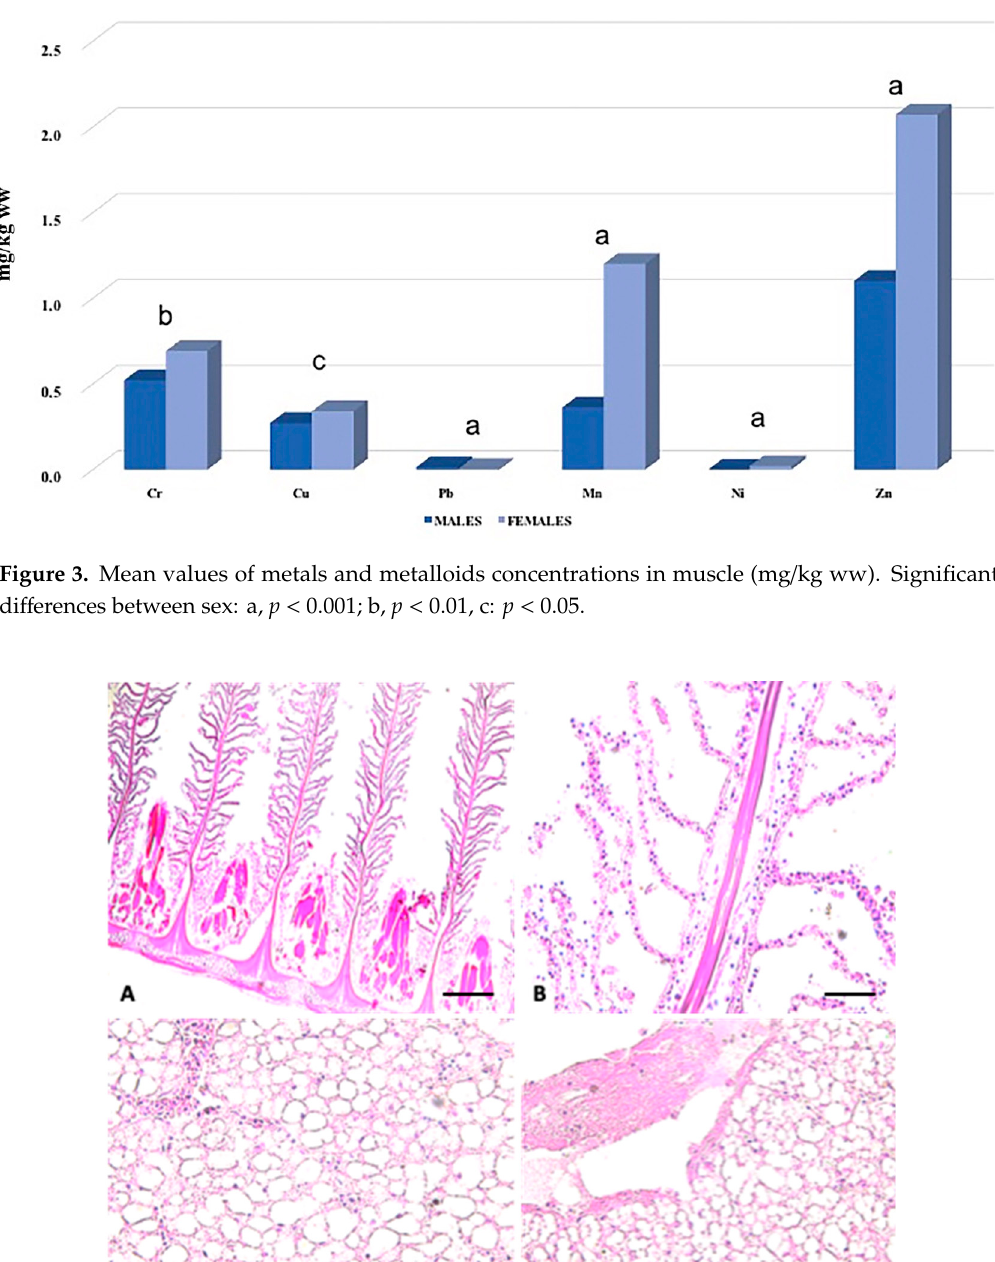
Figure 5. MT 1 expression in male gills ( A ) and liver ( C ). HSP70 expression in male gills ( B ) and in liver ( D ). Using specific antibodies anti-MT1 and anti-HSP70 it has been showed a weak expression of these proteins in cells (green). Scale bar A, C and D: 200 μ m; B: 50 μ m. In recent decades, with the rapid evolution of molecular, biochemical and pathological technologies, biomarkers have found a very wide application. The toxicity of a contaminant on an organism is usually expressed at a biochemical and molecular level and, because of this, at cellular and tissue levels. As a response to the action of a toxic agent, the body develops adaptive responses that tend to bring the system back into a balanced state. However, when the homeostatic mechanism